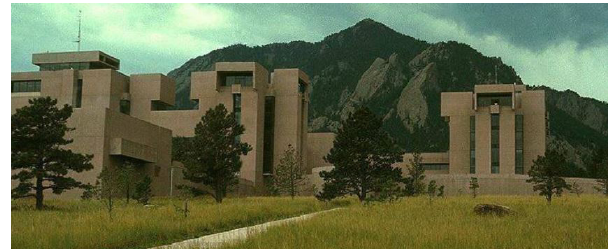
Figure 1. National Center for Atmospheric Research, Boulder, Col- orado USA (©UCAR).